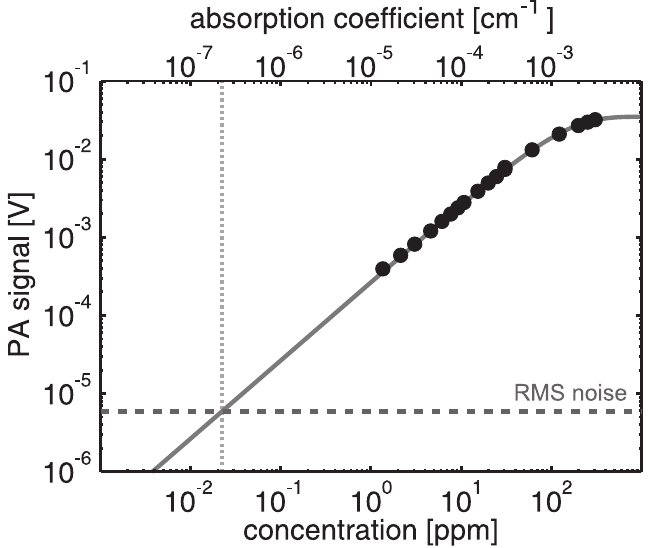
Figure 5. Photoacoustic signal as a function of NO concentration at the resonance 2 frequency of the 2nd longitudinal mode. Central excitation with a diverging laser beam and about 70 passes was used. A simple curve, describing the Beer–Lambert’s law, was fitted to the measured data. The noise level is 5.9 (cid:22) V with 2.1 s measurement time, yielding a detection limit of 22 ppb for NO in N . 2 2